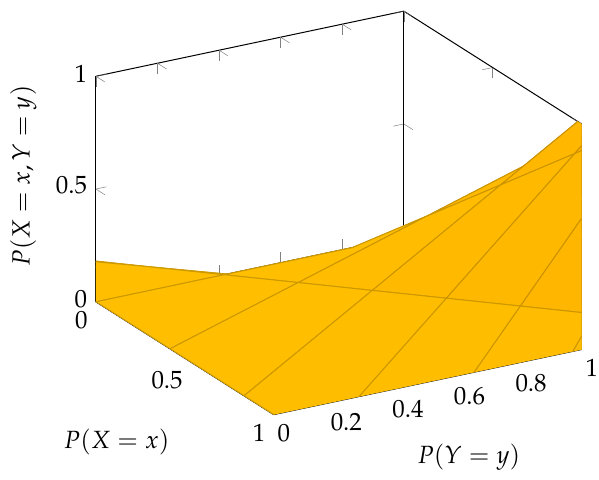
Figure 3. The Set SI for Values x and y